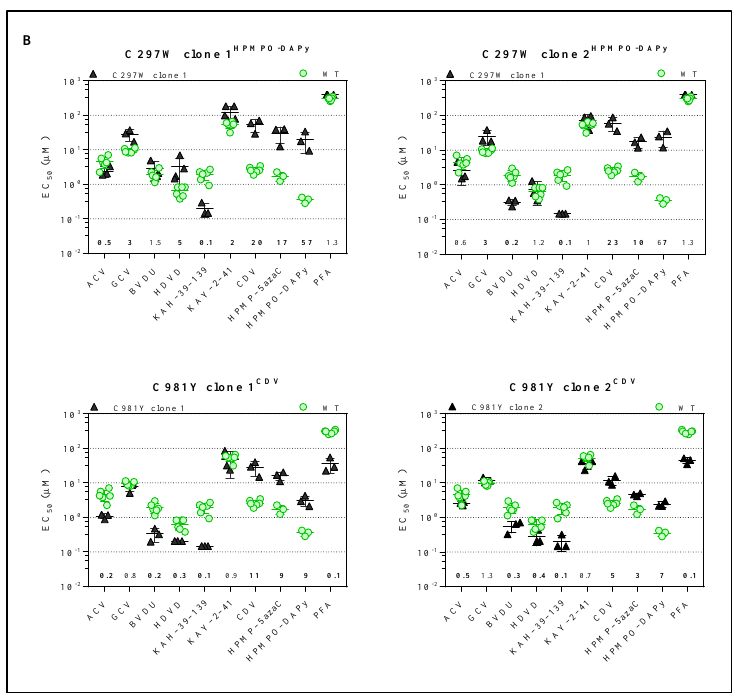
Figure 2. Drug susceptibility profile of MHV-68 wild-type and drug-resistant clones. ( A ) Drug susceptibility profile of viral variants Y383S GCV, Q827R HPMP-5azaC , G302W PFA , K442T PFA and G302W+K442T PFA . ( B ) Drug susceptibility profile of 2 different viral clones of mutator phenotype viruses C297W HPMPO-DAPy and C981Y CDV . In each graph, the wild-type virus is marked with a circle (green), and the drug-resistant virus is marked with a triangle (black). The fold resistance, calculated as the EC 50 of the drug-resistant virus to the wild-type virus, is marked at the bottom of the graph. MHV-68 viral clones were considered drug-resistant or hy persensitive at ≥2 -fold change in EC 50 (bold).